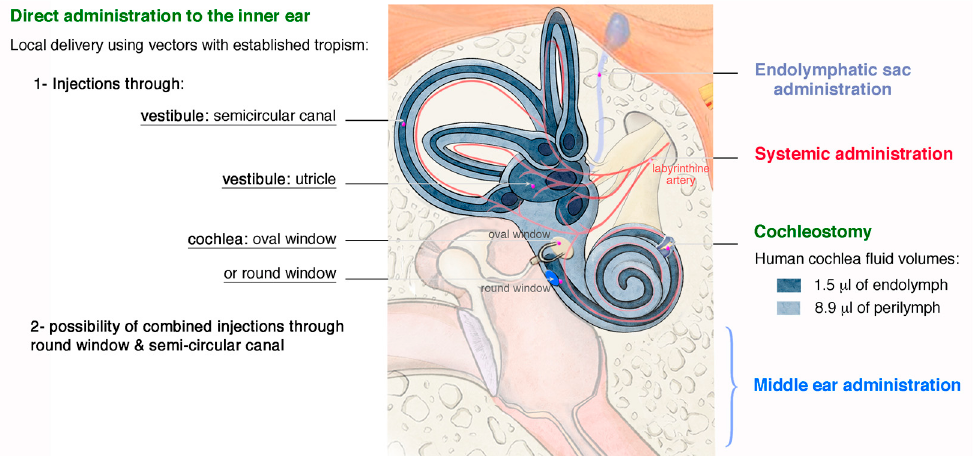
Figure 4. Delivery approaches in the inner ear. Schematic representation of the human ear, illustrating methods used to deliver therapeutics into the inner ear. These include systemic (red) and middle ear (blue) indirect approaches, as well as endolymphatic sac delivery (light blue) and direct injections through different compartments of the inner ear (green): cochleostomy ( scala media ), vestibule (through utricle or semicircular canal), and cochlea (through round window membrane or oval window). Some pros and cons of each methods are highlighted in Table S2.